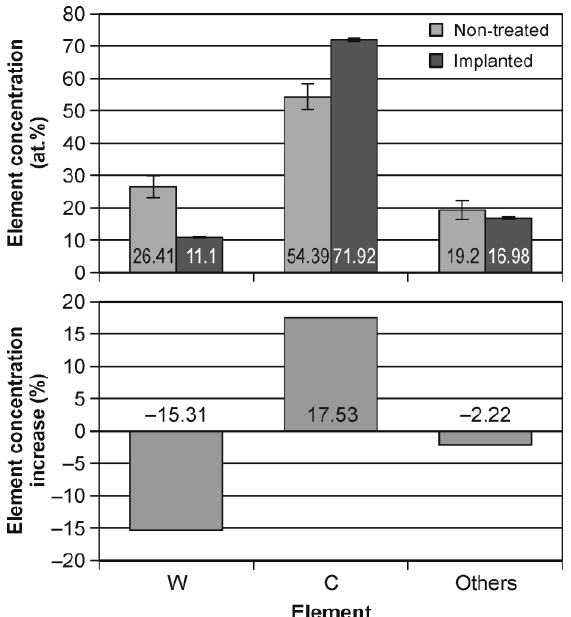
Figure 12. The concentration of elements on the surface of non-treated and ion-implanted tools af- ter tool life tests and percentage increase in elements ’ concentration. tool life tests and percentage increase in elements’